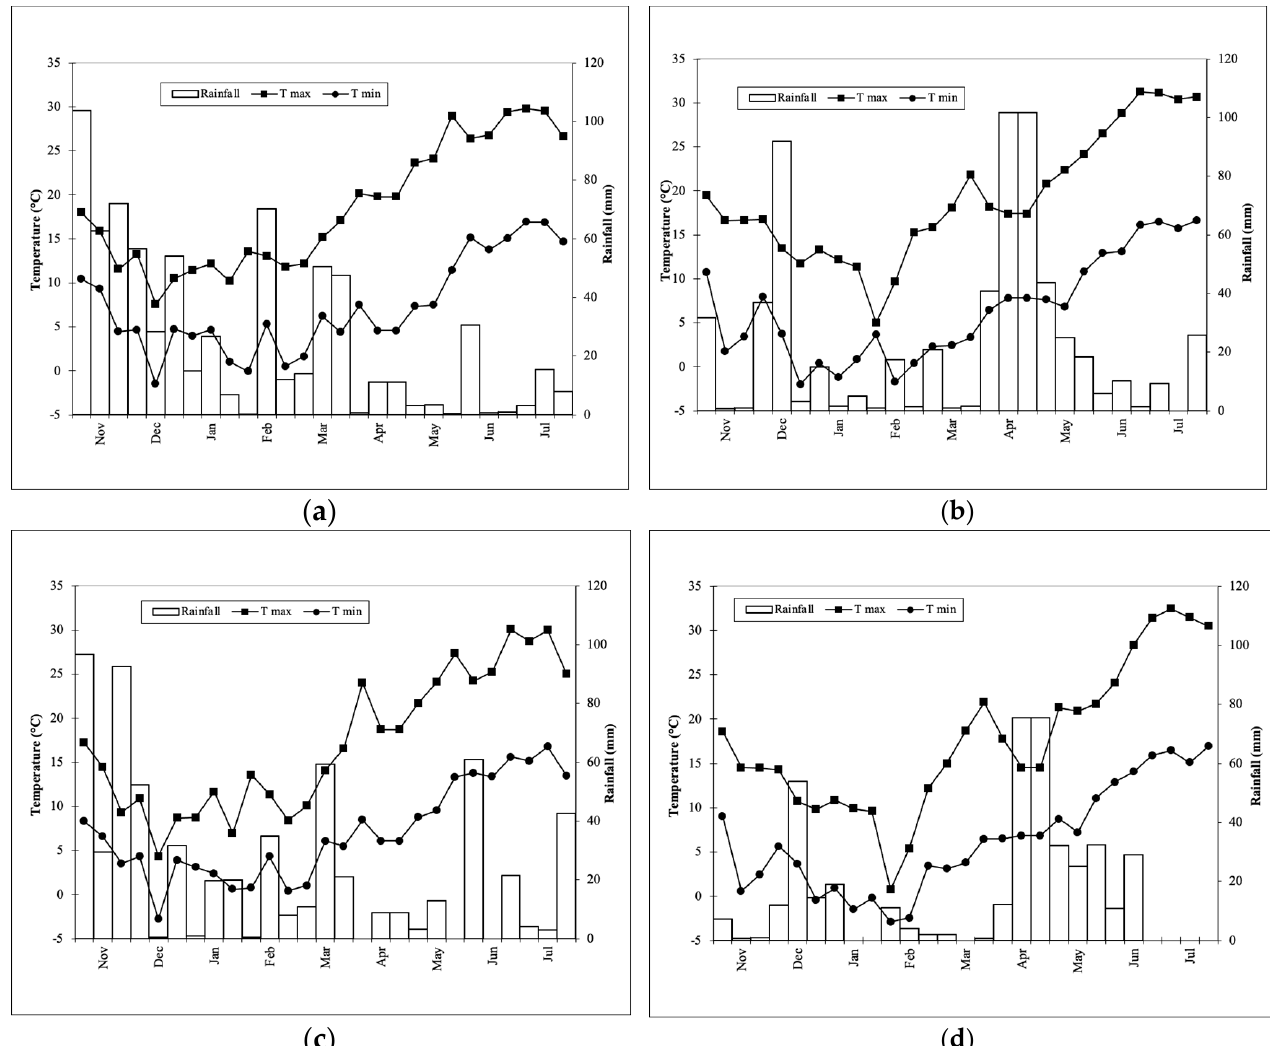
Figure 1. Maximum and minimum temperature and rainfall recorded in the two durum wheat growing seasons at the two locations: ( a ) Pisa first season (November 2010–June 2011); ( b ) Pisa second season (November 2011–June 2012); ( c ) Arezzo first season (November 2010–June 2011); ( d ) Arezzo second season (November 2011–June 2012). At Pisa, rainfall during the crop cycle was similar in both years (about 475 mm) and slightly lower than the long-term average (515 mm). At Arezzo, rainfall differed between years and was 413 mm in 2010 and 351 mm in 2011, correspondingly similar to 30% lower than the long-term average (499